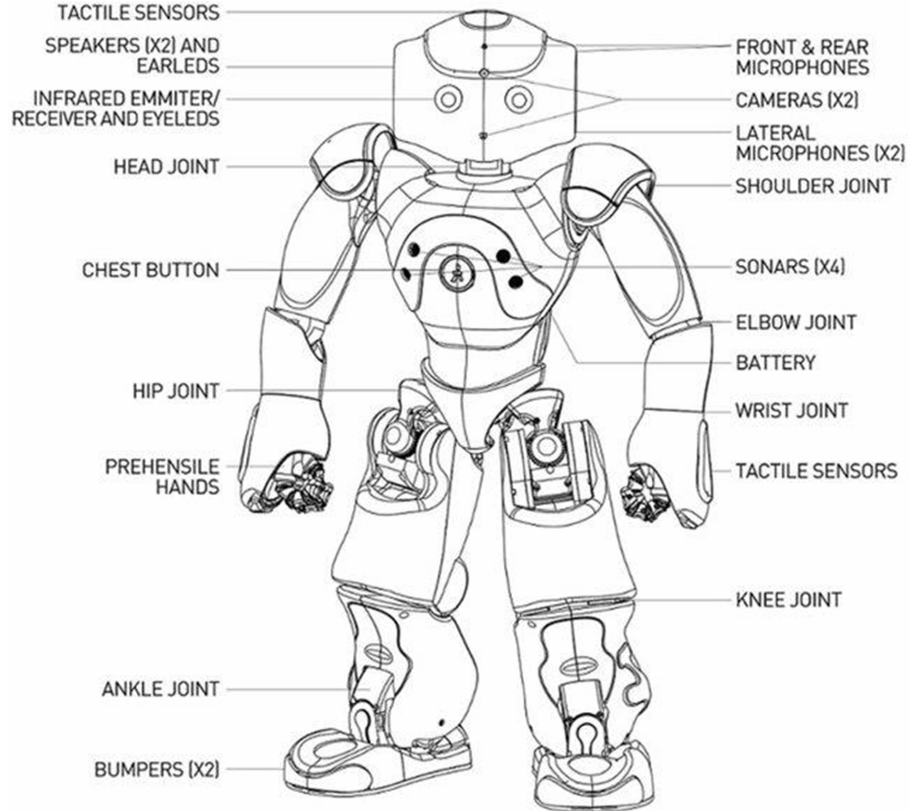
Figure 2. All sensors in NAO robot [29].